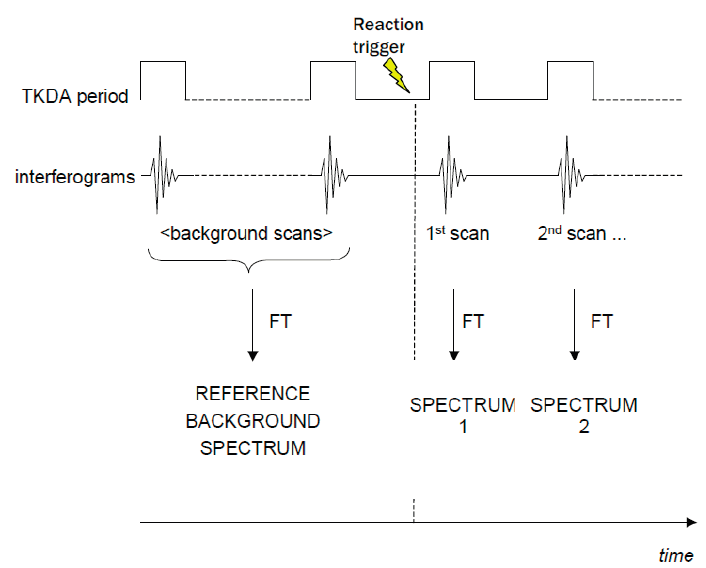
Figure 2. Scheme of a rapid-scan FTIR-DS experiment using a laser flash to trigger the photo-reaction.